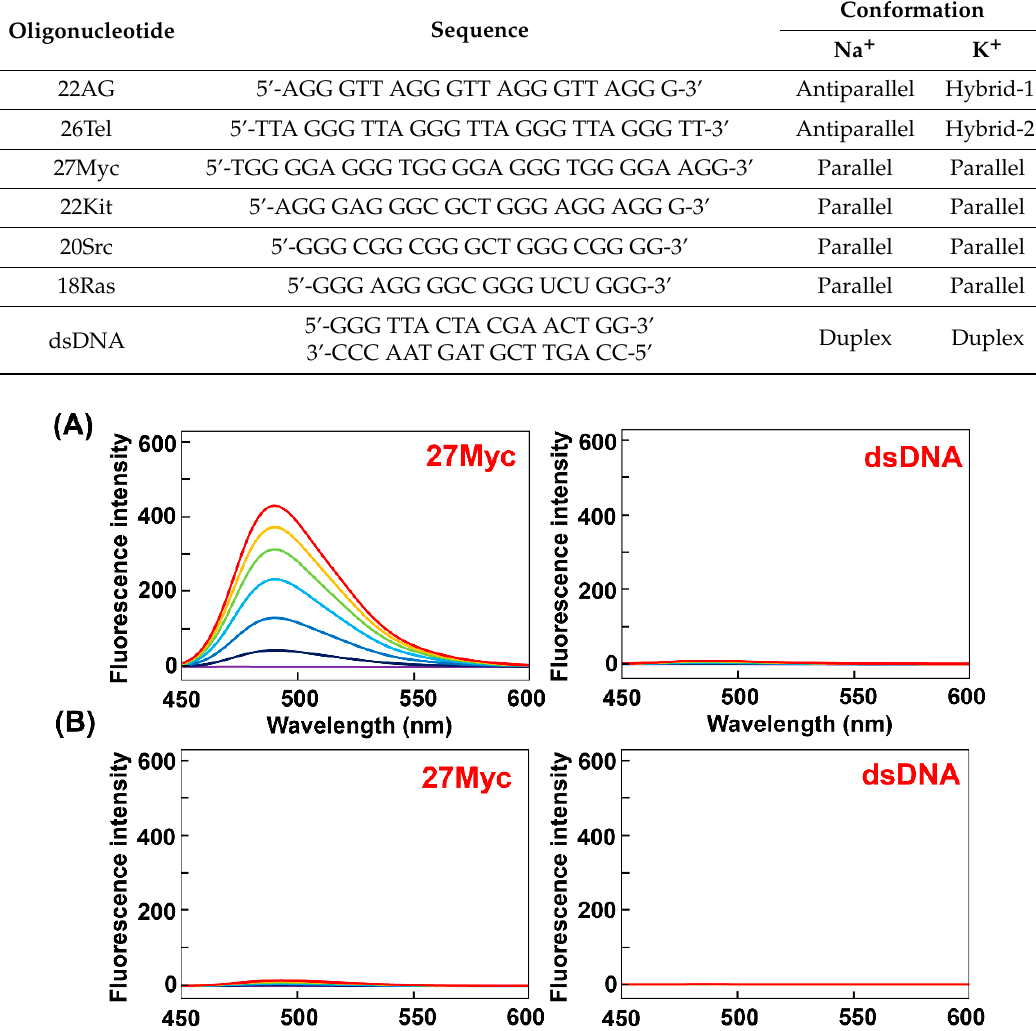
Table 1. Synthetic oligonucleotides used in this study.